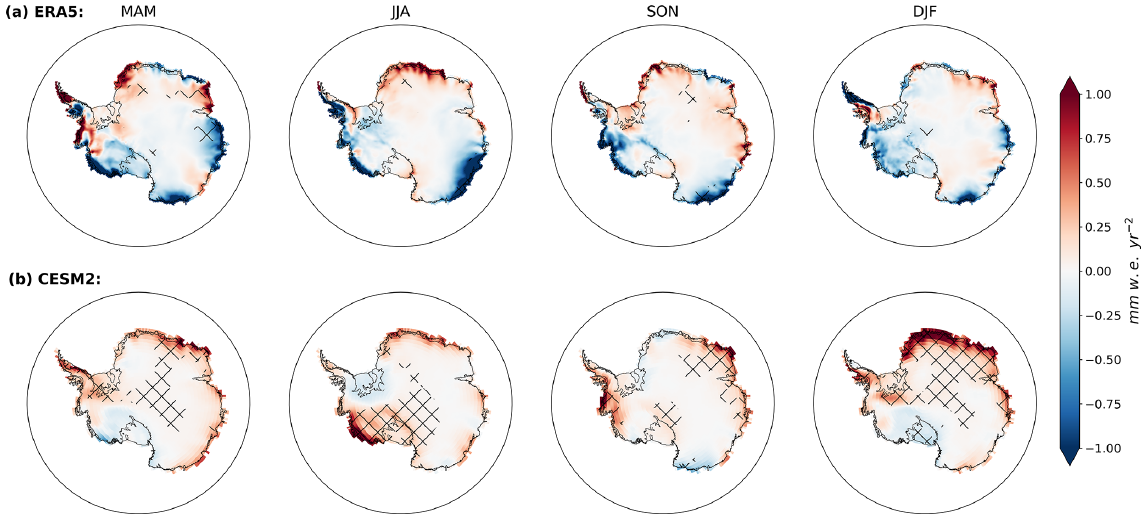
Figure 7. 1979–2015 trend in seasonal precipitation from (a) ERA5 and (b) CESM2. Cross-hatched areas represent regions where this trend is significant ( p <